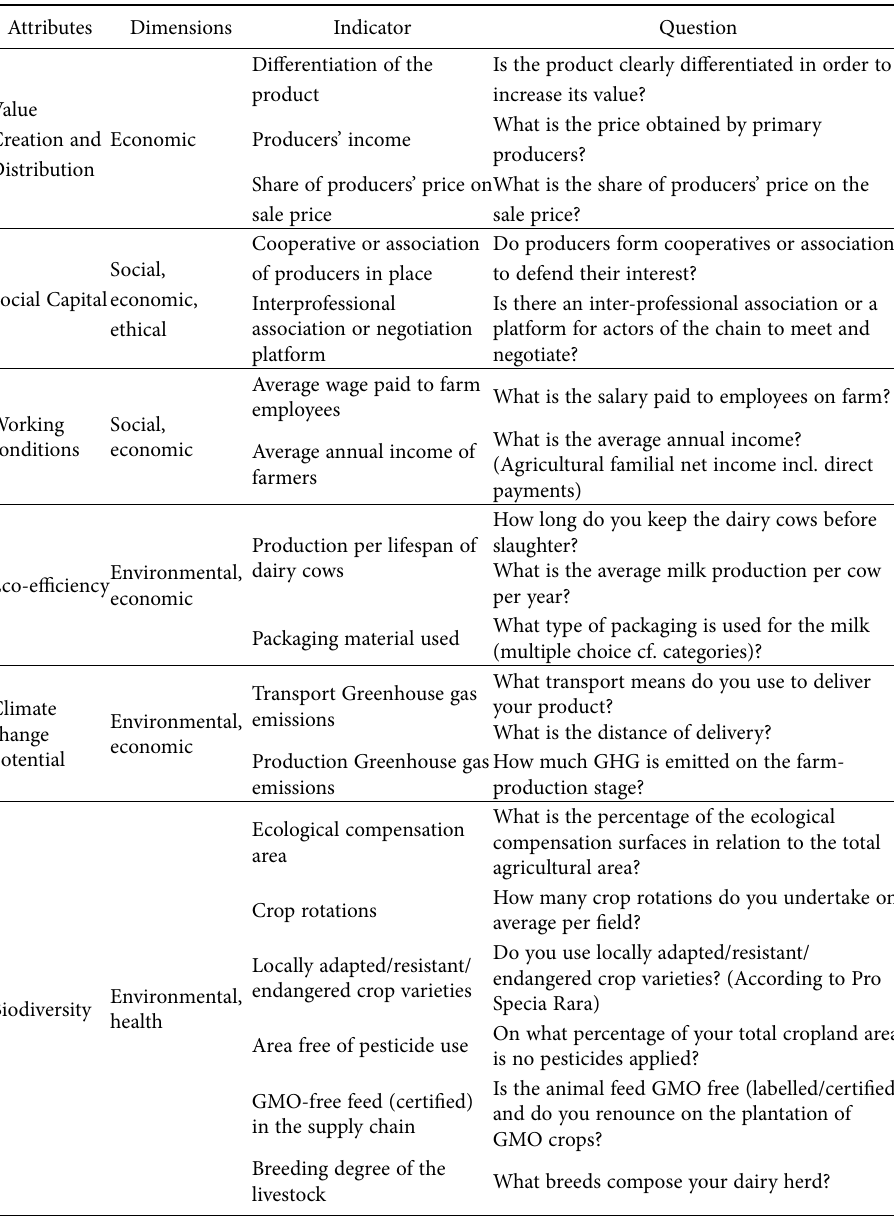
Table 1. Attributes and indicators for the sustainability assessment. Attributes Dimensions